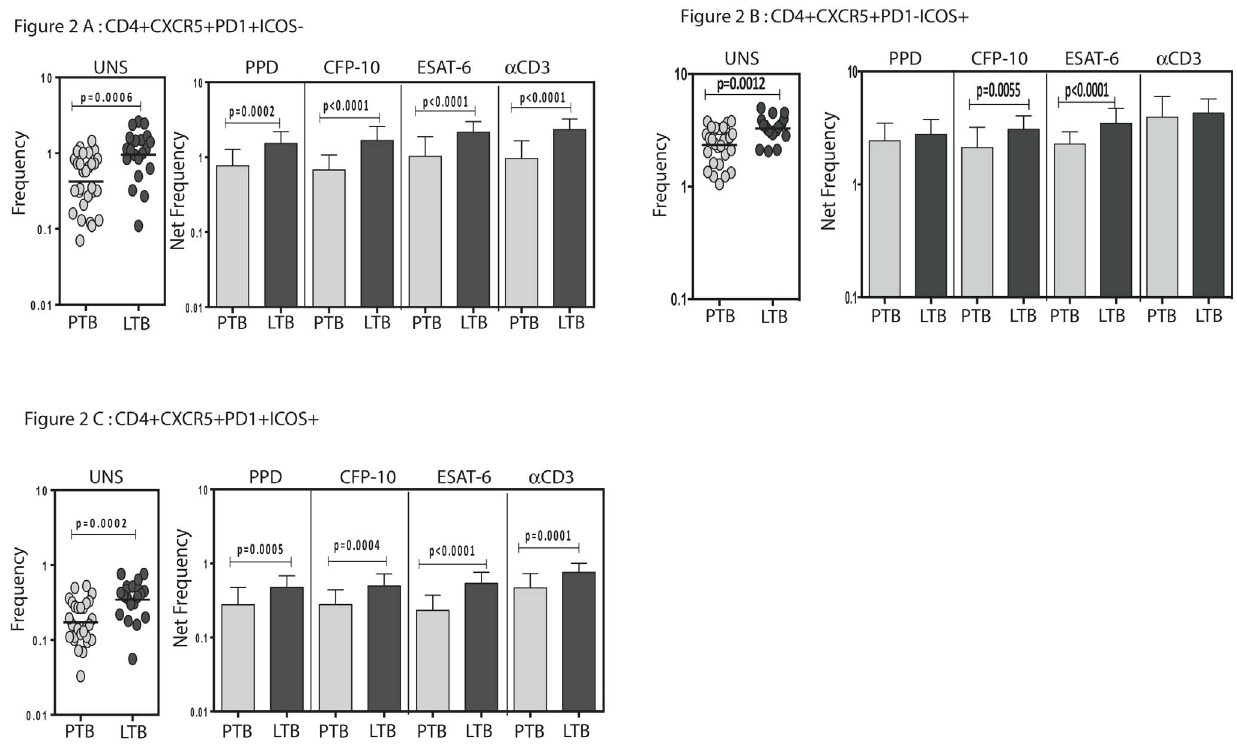
Figure 2. Diminished spontaneous and antigen - specific frequencies of Tfh subsets in PTB and LTB. Whole blood from PTB and LTB individuals was stimulated with PPD, CFP-10, ESAT-6 and anti-CD3 for 6 h, and the frequencies of (A) CD4 + CXCR5 + PD-1 + ICOS 2 ; (B) CD4 + CXCR5 + PD- 1 2 ICOS + and (C) CD4 + CXCR5 + PD-1 + ICOS + T cells were estimated by flow cytometry. Spontaneous frequencies are shown as scatter plots and stimulated frequencies as bar graphs. The bars represent geometric means and 95% confidence intervals. Spontaneous frequencies are shown as raw frequencies and the stimulated frequencies are shown as net frequencies with the spontaneous frequency subtracted. P values were calculated using the Mann-Whitney U